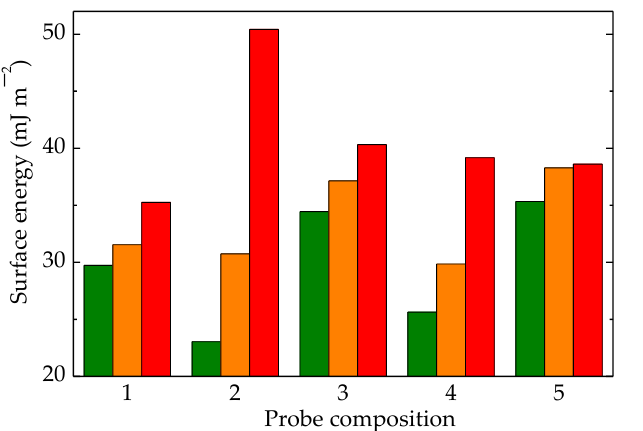
Figure 12. Surface energies calculated for LDPE/UHMWPE samples irradiated at (olive) 0 kGy, (orange) 50 kGy, and (red) 100 kGy. (1) LDPE/UHMWPE, (2) LDPE/HAp, (3) LDPE/HAp/RM, (4) LDPE/UHMWPE/HAp, (5) LDPE/UHMWPE/HAp/RM.